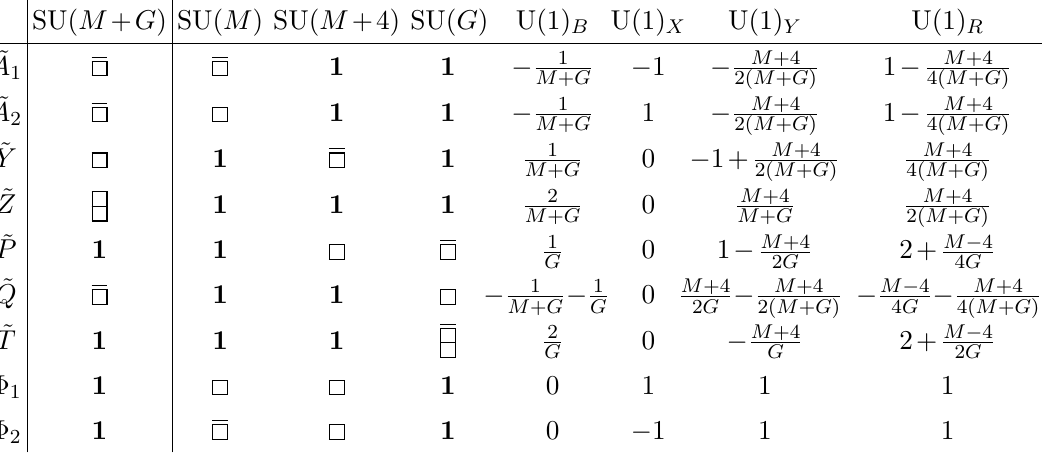
Table 2. The charge table for Q B . Note that this can be obtained from table 1 by charge USp conjugating U(1) X , U(1) Y and the non-abelian groups, replacing F with G and adding the mesons Φ 1 = A 1 Y and Φ 2 = A 2 Y .